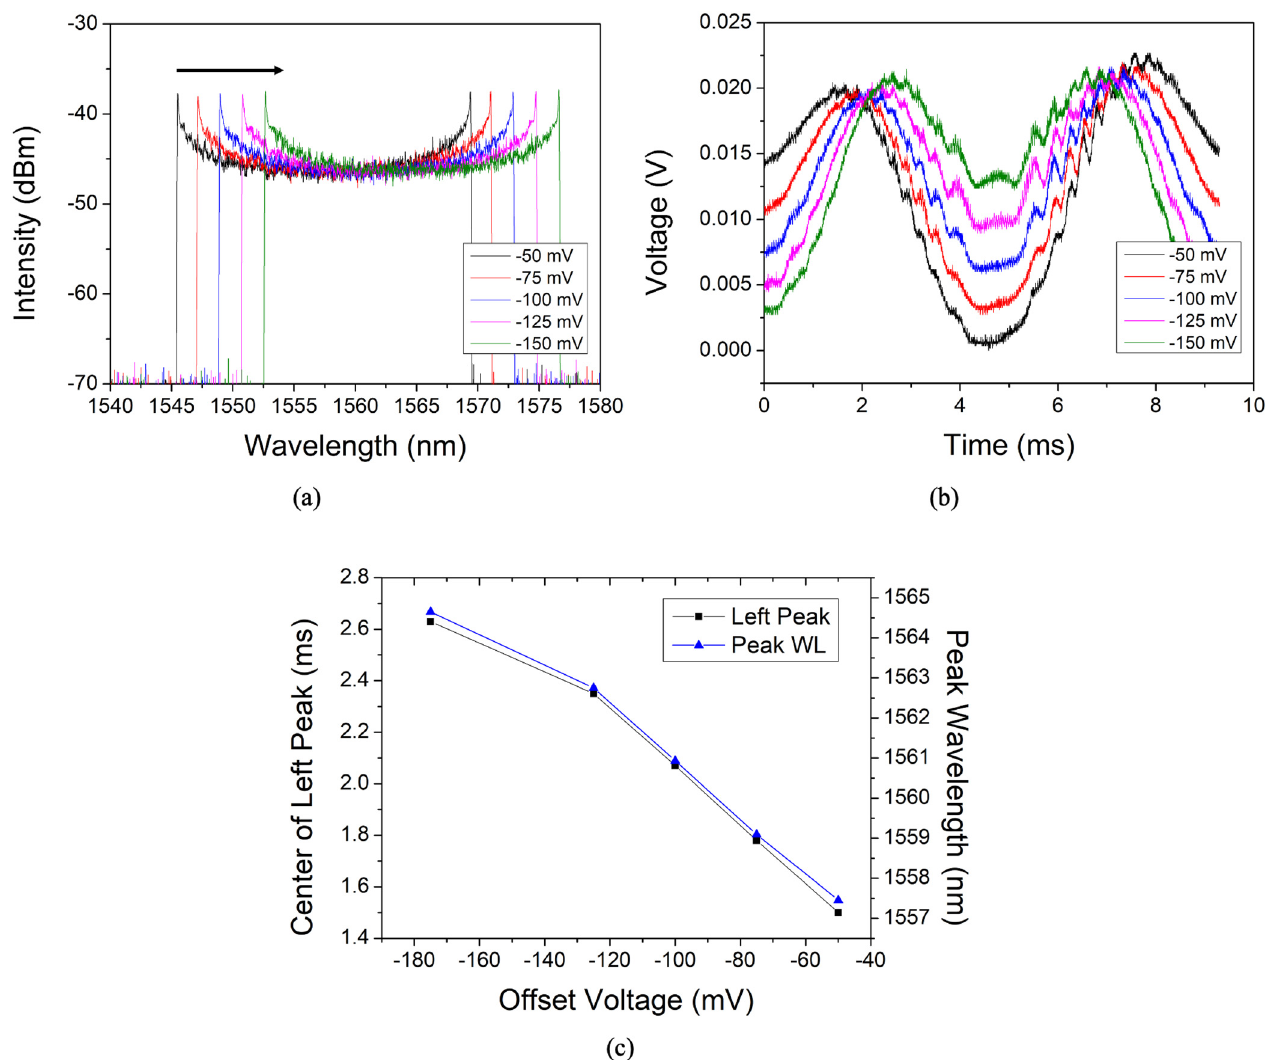
Figure 4. ( a ) WSL outputs in the spectral domain; ( b ) WSL outputs in the temporal domain; and ( c ) the variation of the center wavelength of WSL output in the spectral domain (right axis) and the variation of the forward scan peak in the temporal domain (left axis) with respect to V offset .